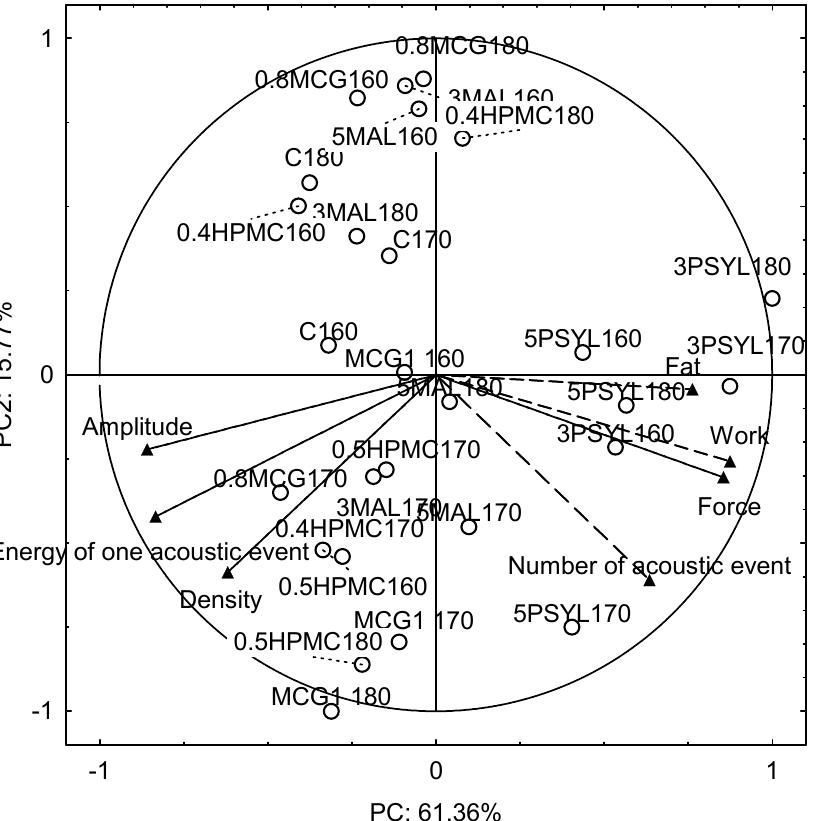
Figure 1. The principal component analysis (PCA) of instant noodles’ texture properties. Table 4. The correlations between texture properties, density, and fat.